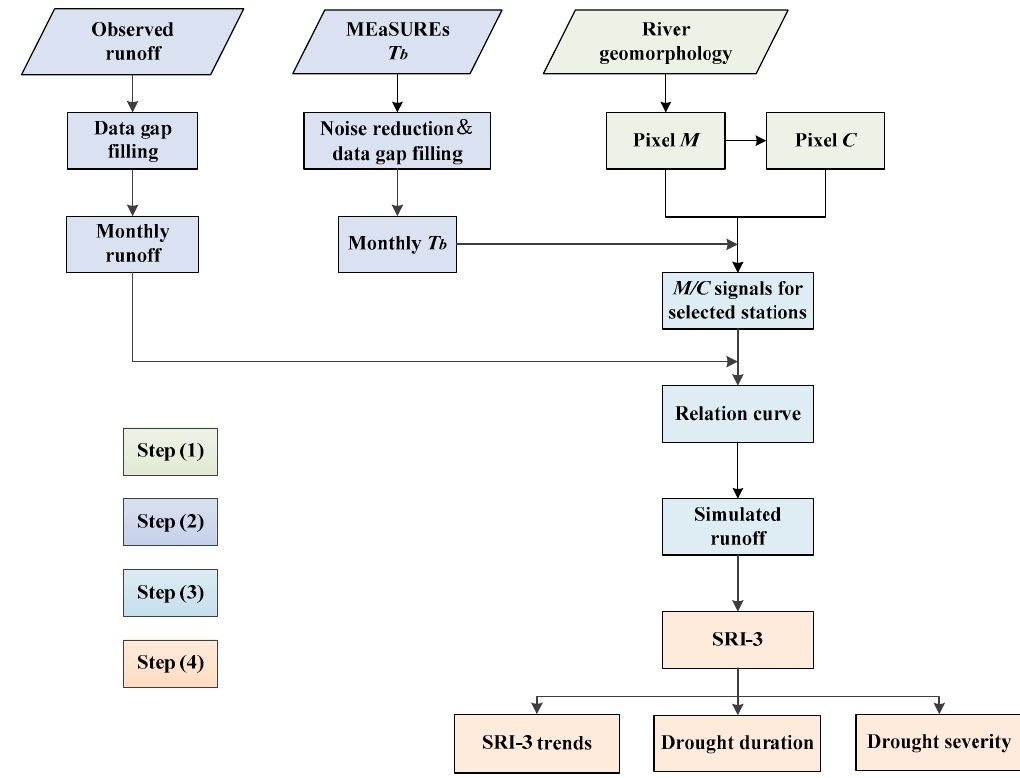
Figure 2. Methodological workflow to assess hydrological drought based on passive microwave remote sensing.